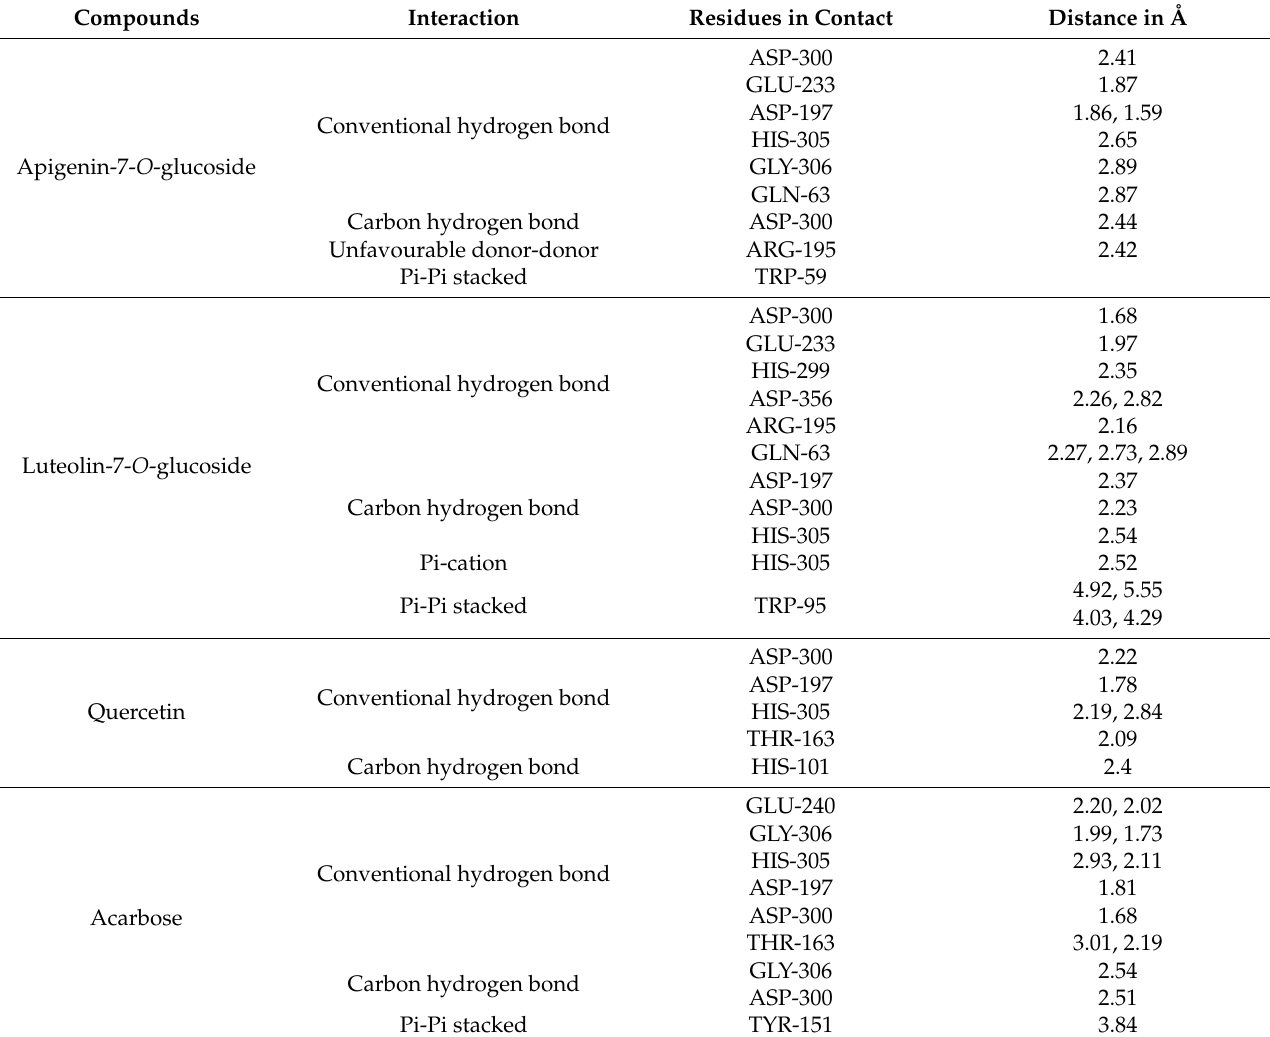
Table 1. Data for the molecular docking of apigenin-7- O -glucoside, luteolin-7- O -glucoside, quercetin, and control acarbose with alpha-amylase